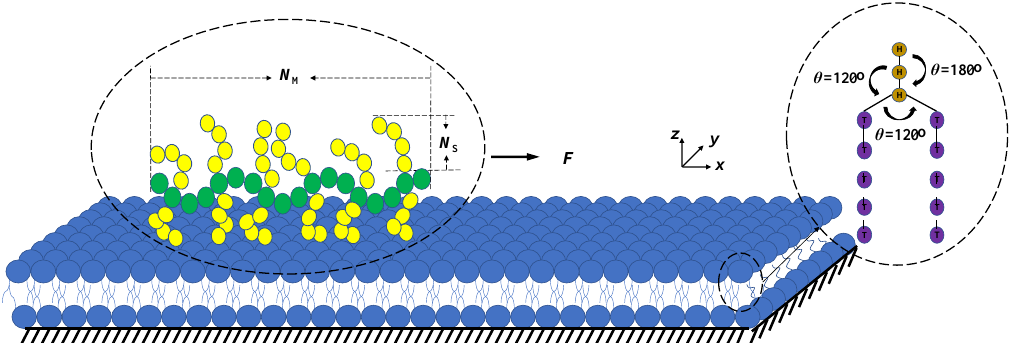
Figure 1. Schematic view of the phospholipid membrane and bottlebrush polymer model. The coarse-grained phospholipid polymer chain is constructed by one hydrophilic chain (the upper gold beads), and the two hydrophobic chains (the bottom purple tail beads). The bottlebrush polymer is placed in the phospholipid membrane where the main chain is marked as green and side chains are marked as yellow. The membrane is supported by a substrate where two heads beads are fixed in the lowermost layers. The pulling forces are applied along the x